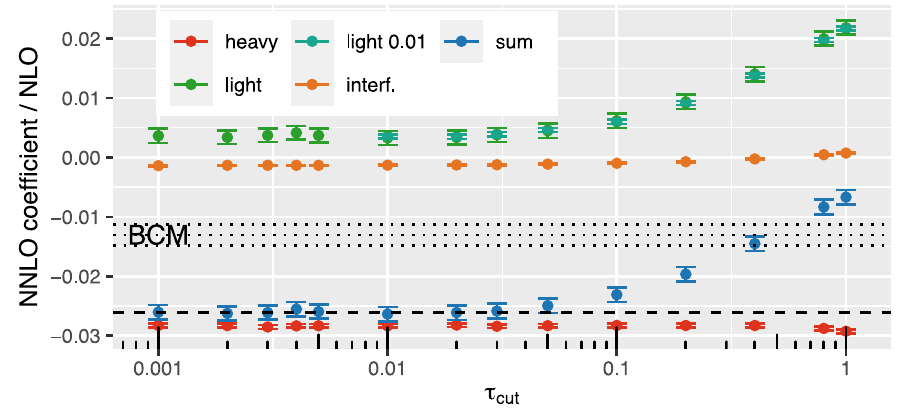
Figure 7 . τ cut dependence of NNLO light, heavy, interference and summed contributions relative to the NLO part for the fully inclusive result in table 2. The dotted area represents the NNLO coefficient with an absolute uncertainty of ± 0 . 1 pb to obtain the result from Brucherseifer, Caola, Melnikov (BCM) [36].